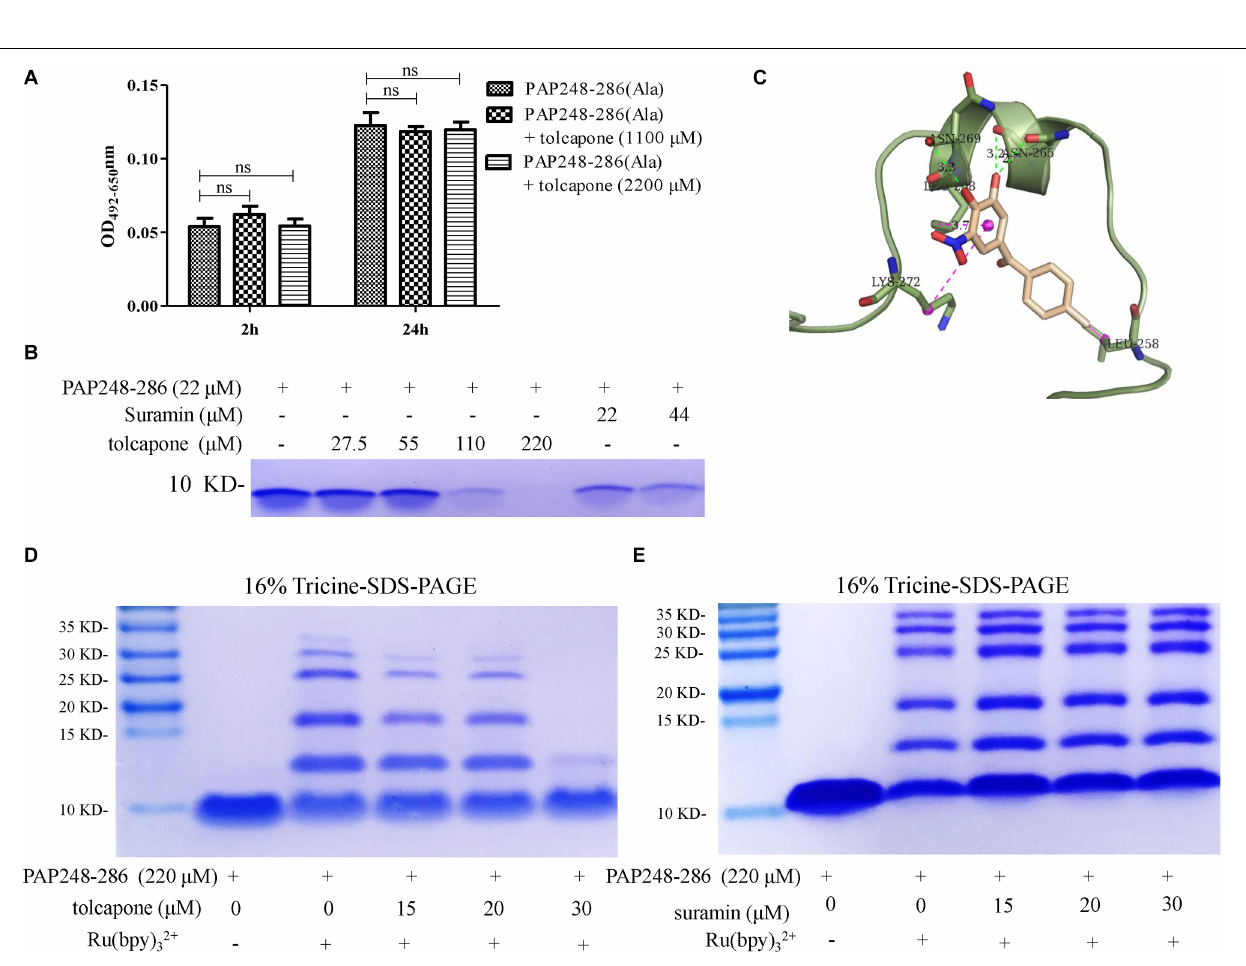
FIGURE 4 | Tolcapone inhibits oligomerization of PAP248–286 monomers. (A) PAP248–286(Ala) (220 µ M) were agitated with or without tolcapone. Fibril formation was detected by Congo red staining at 2 and 24 h. The data represent means ± SD of three independent experiments. (B) PAP248–286 at 22 µ M was incubated with tolcapone or suramin at different concentrations at 37 ◦ C for 30 min. The remaining free PAP248–286 in the supernatants after centrifugation at 5,000 rpm for 10 min was recognized by Coomassic blue. (C) Presumed binding sites of tolcapone to PAP248–286. According to the computational docking results, tolcapone formed hydrogen bonds with ASN265 and ASN269, and it bound to LYS272, LEU258, and LEU268 by π – π interactions. (D) The effects of tolcapone on the oligomerization of PAP248–286 were assessed using 16% tricine-sodium dodecyl sulfate (SDS)-polyacrylamide gel electrophoresis (PAGE) and Coomassie blue staining. PAP248–286 monomer at 220 µ M with or without cross-linking served as the control. (E) Suramin showed no ability to inhibit the oligomerization of